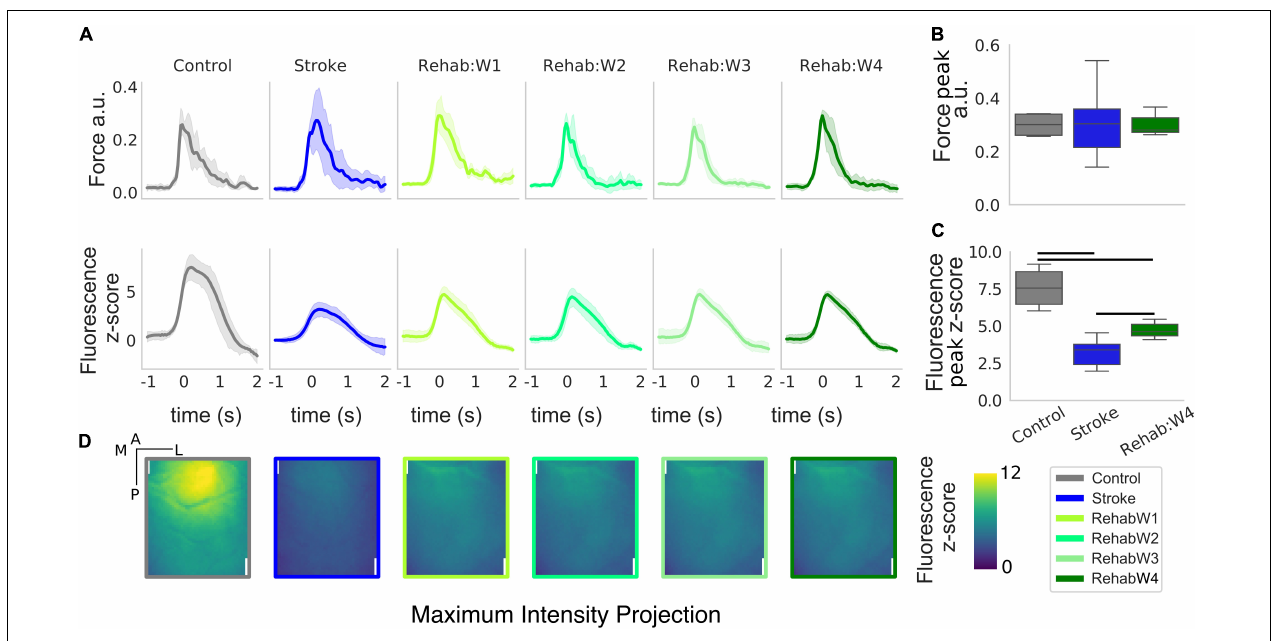
FIGURE 2 | The peak and the spatial distribution of the calcium transient are partially recovered in the rehabilitation group. (A) Force and calcium profiles, top and bottom rows, respectively, in response to the rewarded pull for all treatment groups. Time is referenced to the end of the retraction phase which precedes the force peak. Boxplot of the peak force (B) and peak fluorescence (C) for all subjects. For each box, the middle line represents the median. The box spans the interquartile range (IQR) (25–75%) while the whiskers extend to show the rest of the distribution excluding points that are far apart 1.5 times the IQR. Horizontal bars denote statistically significant differences among groups. (D) Maximum intensity projection, the maximum intensity of the fluorescent stack in the time window ranging from –1 to 2 s after the rewarded pull computed for each individual pixel. Scale bars in the top right corner of the first figure are 1 mm in